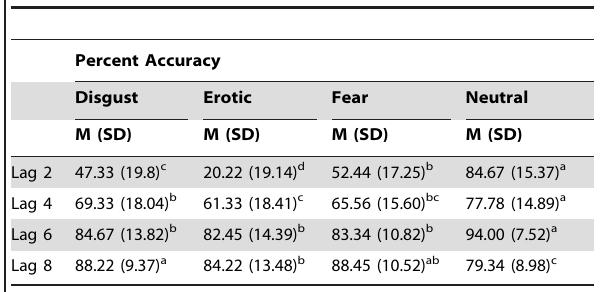
Table 1. Raw means and standard deviations of percent correct (accuracy) for the target for each emotional distracter category by lag interval.